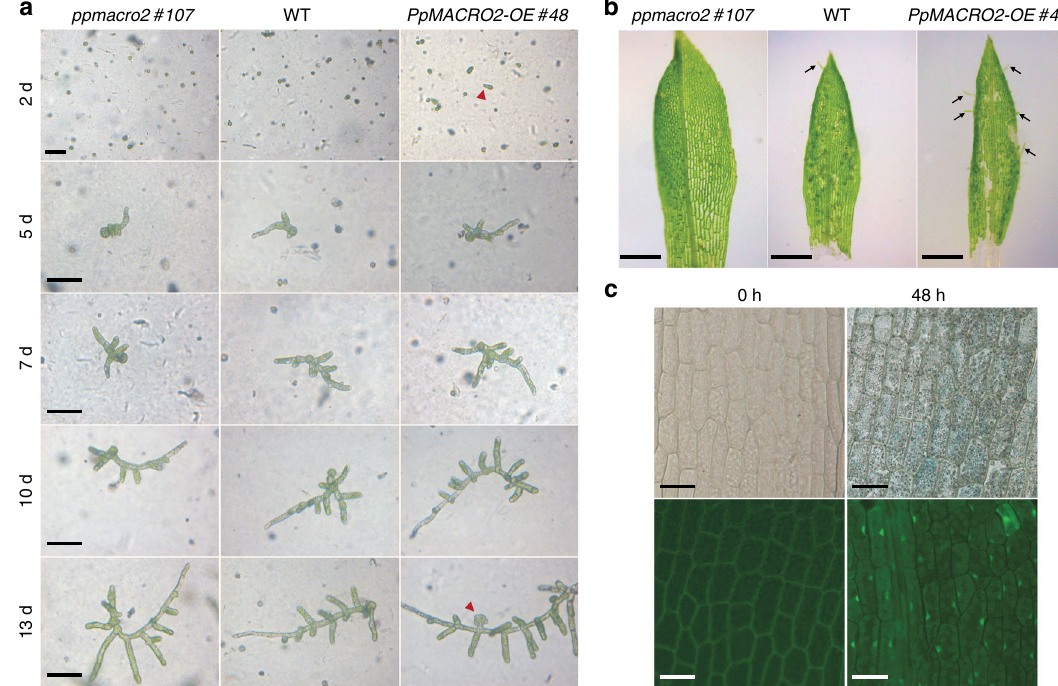
Fig. 5 PpMACRO2 promotes cell reprogramming in P. patens . a Protoplast regeneration, with red arrowheads indicating differentiated cells and buds. b Tissue regeneration using detached leaves from WT plants, as well as ko and OE mutants of P. patens . Black arrows indicate emerged protonema fi laments. c GUS staining and GFP fl uorescence of leaves were observed from PpMACRO2-EGFP-GUS transgenic lines after being detached for 48 h. Micrograph images shown were observed from fi ve biological replicates. Scale bars: 100 μ m in a , c ; 500 μ m in b